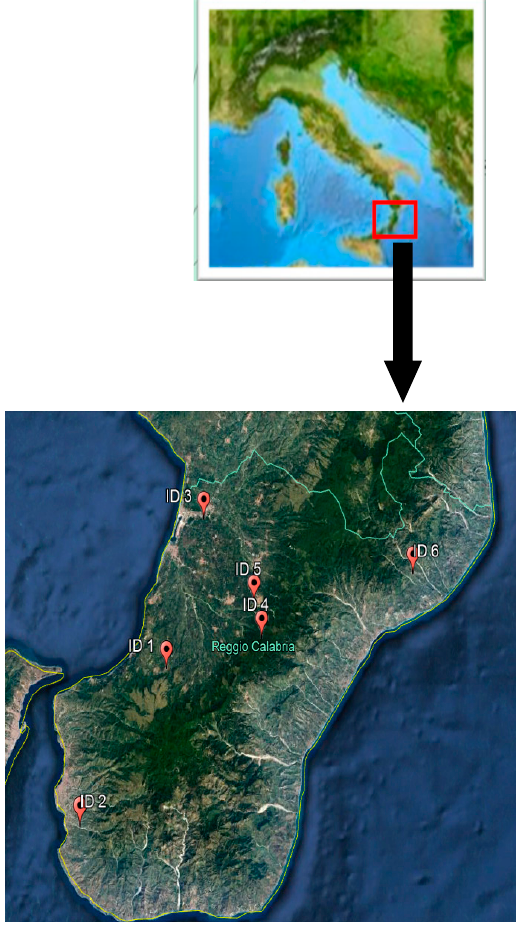
Figure 1. The map of the sampling points.